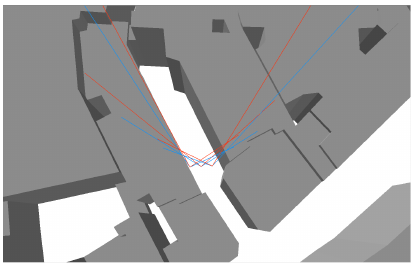
Figure 8: Fenchurch Buildings - Variation Across the Street mum variation of -75 ◦ between OSMM Max and VMD Max, in- dicating that the VMD Max value is high where the OSMM Max value is low. This corresponds to the 300 ◦ azimuth angle, which is characterized by an extended corner (created by the general- ization process) on the VMD building in contrast to the smooth corner on OSMM. A similar issue can be seen at 270 ◦ azimuth (i.e. due west) where the ray will intersect the OSMM build- ing, with an angle of 76.64 ◦ for OSMM Max, yielding 55.54 ◦ for VMD (due to the building further away to the left) and 4.92 for OSM as there are no close buildings west of the point (there is a building further away, as can be seen in the smaller scale map in Figure 3).